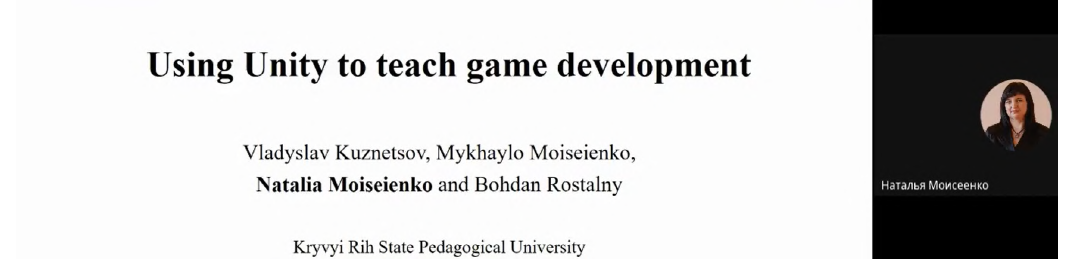
Figure 12: Presentation of paper